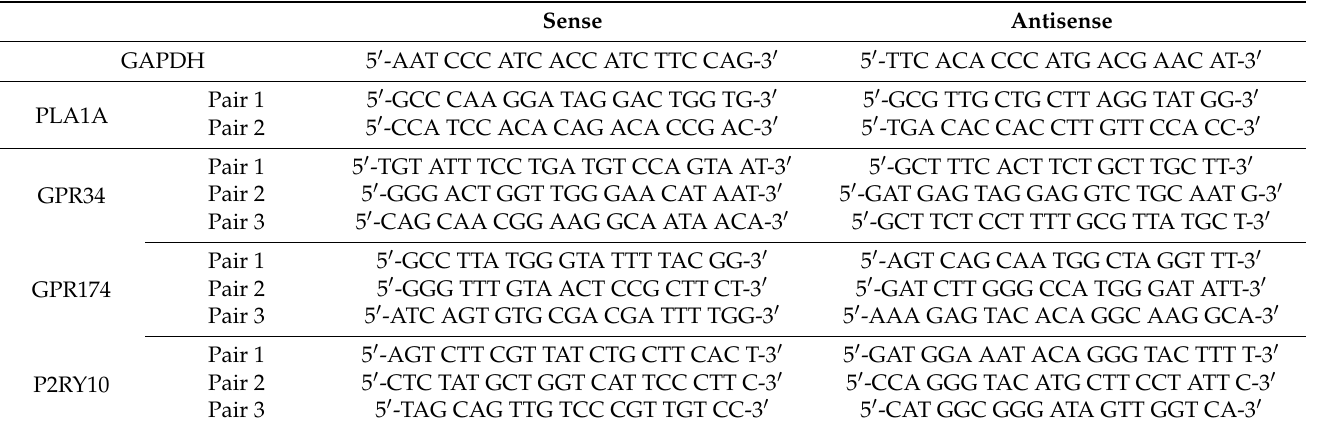
Table 1. List of primers used in this